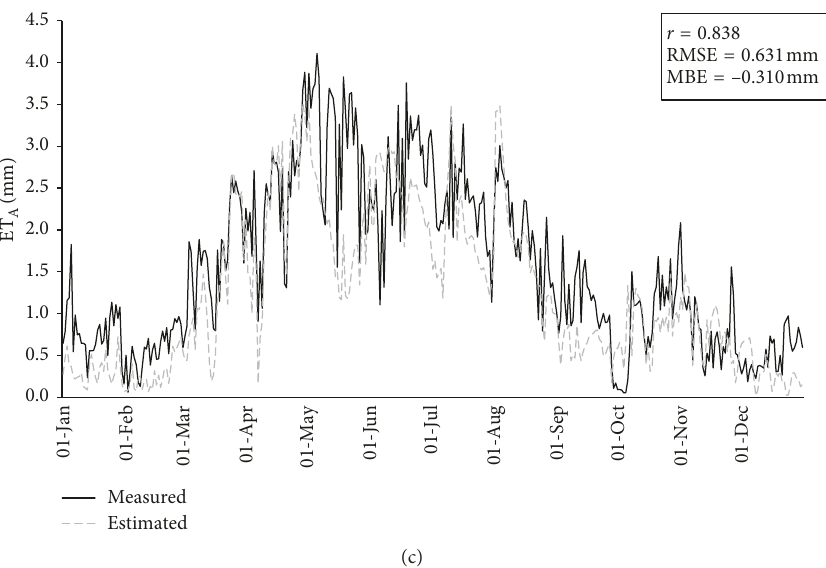
0 ) (a), measured and calibrated SWC A